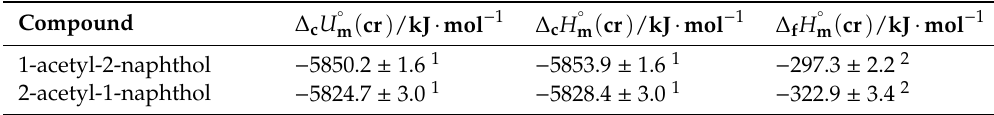
Table 1. Derived standard ( p = 0.1 MPa) molar values from combustion calorimetry experiments